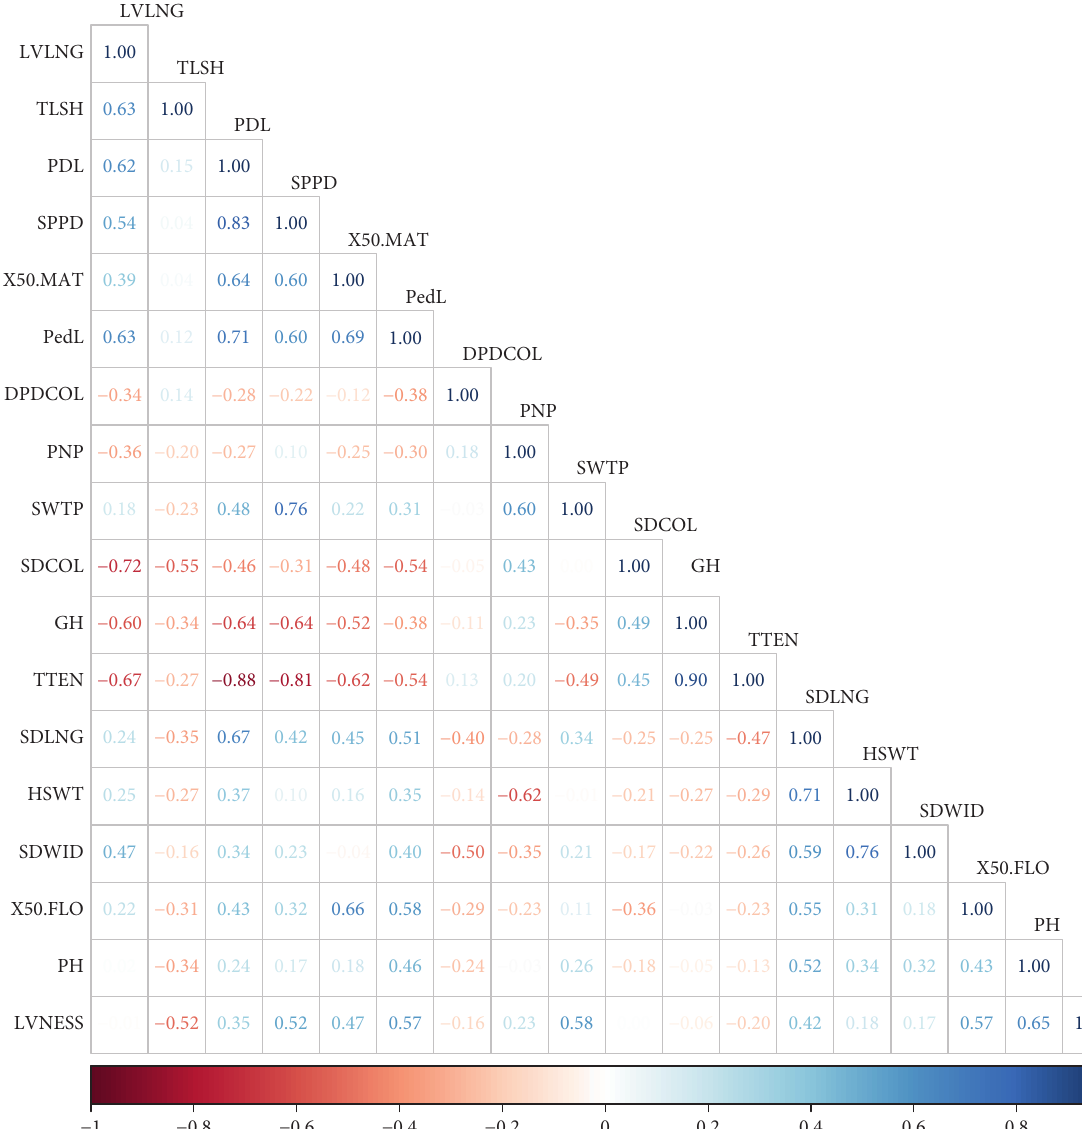
Figure 3: Correlations with P value > 0.05 were considered insignificant, and their correlation coefficient values were left